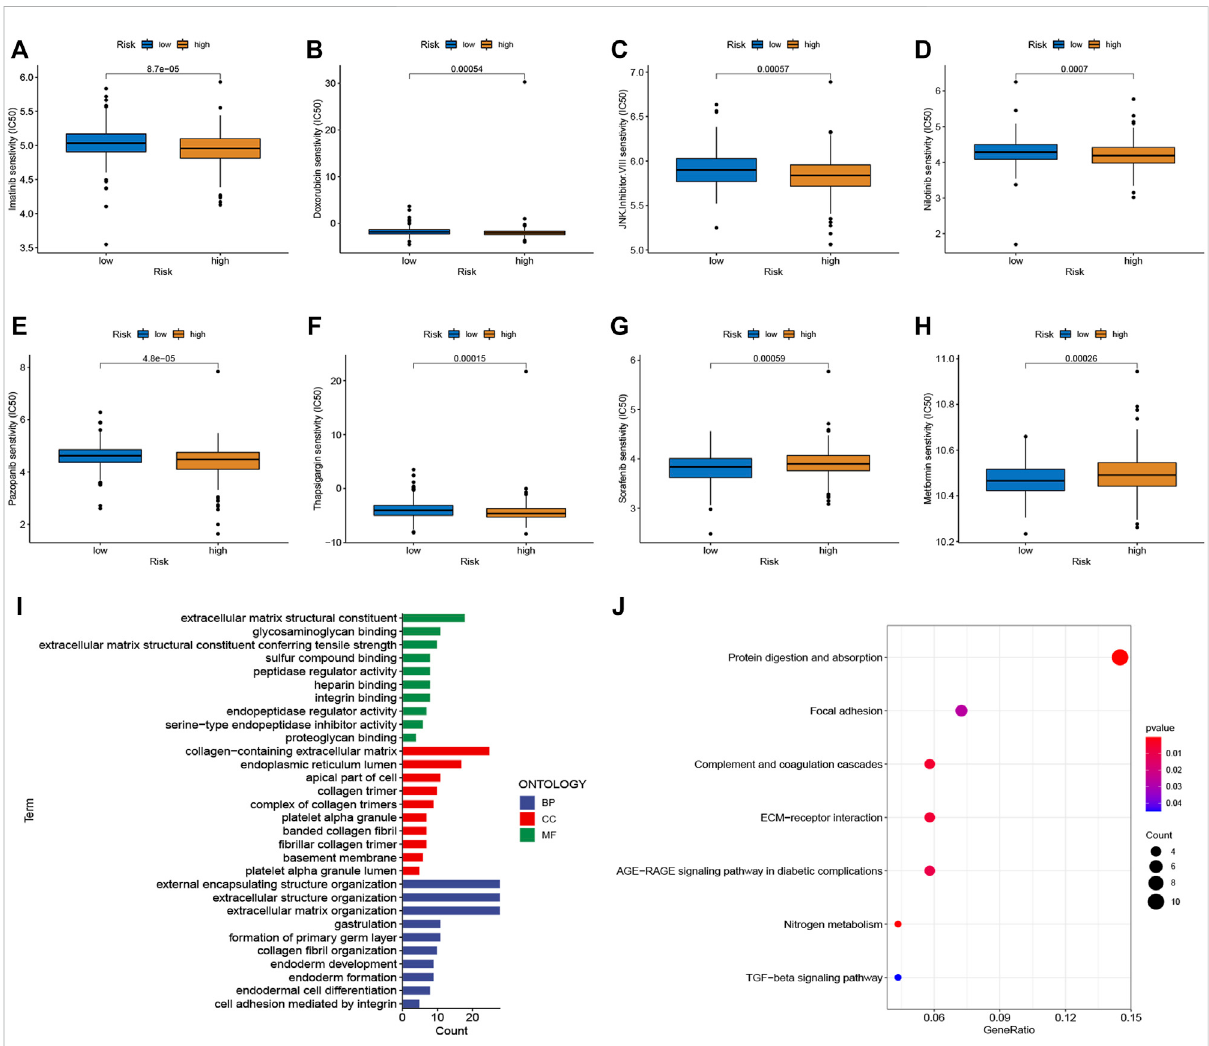
FIGURE 6 Chemotherapysensitivityandfunctionalenrichmentanalyses. (A – H) BoxplotsoftheIC50valuesoftheImatinib,Doxorubicin,JNKInhibitorVIII, Nilotinib, Pazopanib, Thapsigargin, Sorafenib, and Metformin between different risk subgroups. (I) Top enriched gene pathways/functions using GO terms of biological process, cellular component, and molecular function. (J) KEGG pathway analysis of DEGs between two risk groups. The bigger bubble represents more genes enriched, and the redder color means more obvious